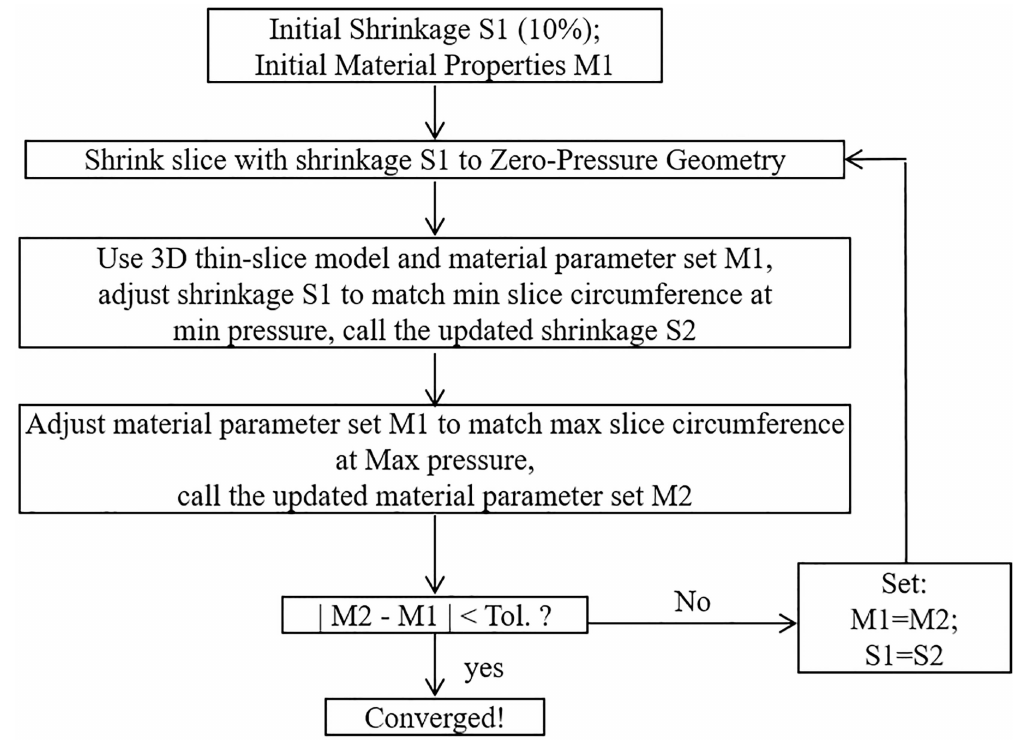
Fig 4. The flow chart for the iterative procedure to determine material parameters and vesselcircumferential shrinkage rate.